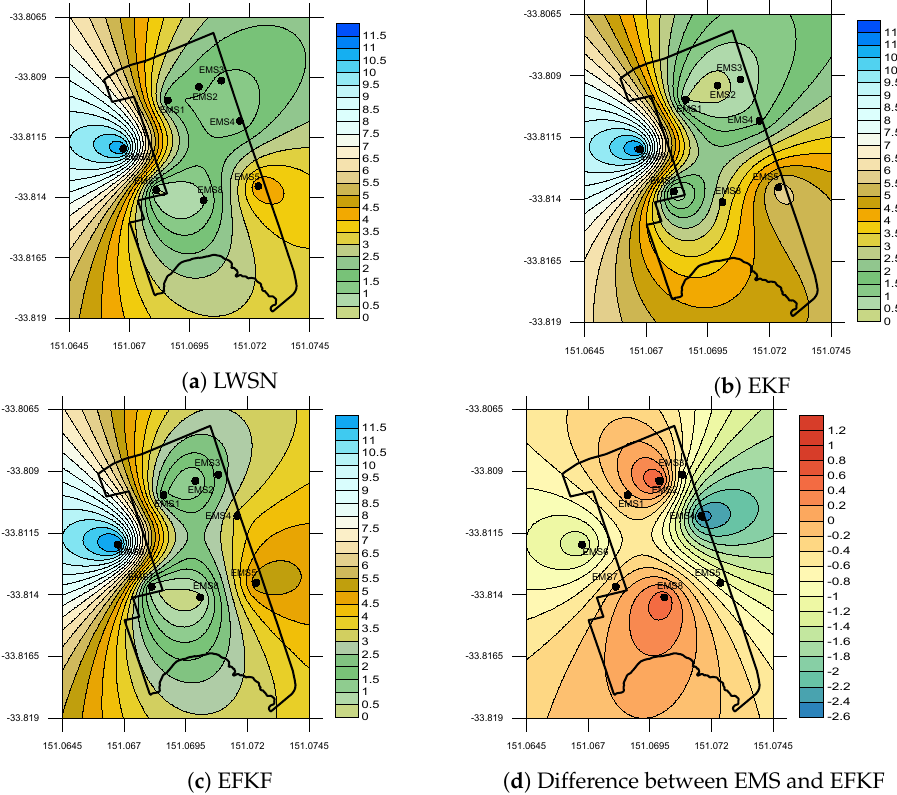
Figure 7. Local PM2.5 ( µ g/m 3 ) concentration on 19 December 2019 at 0:15